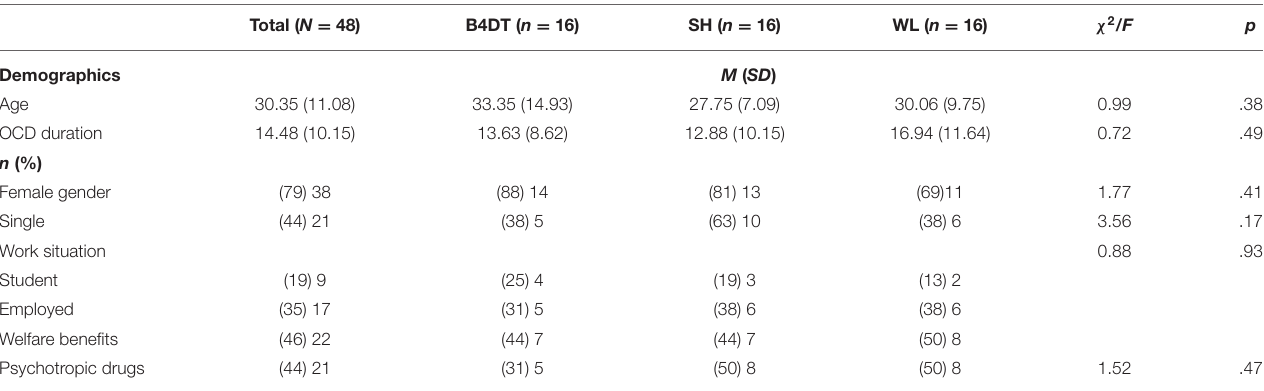
TABLE 1 | Demographic characteristics at